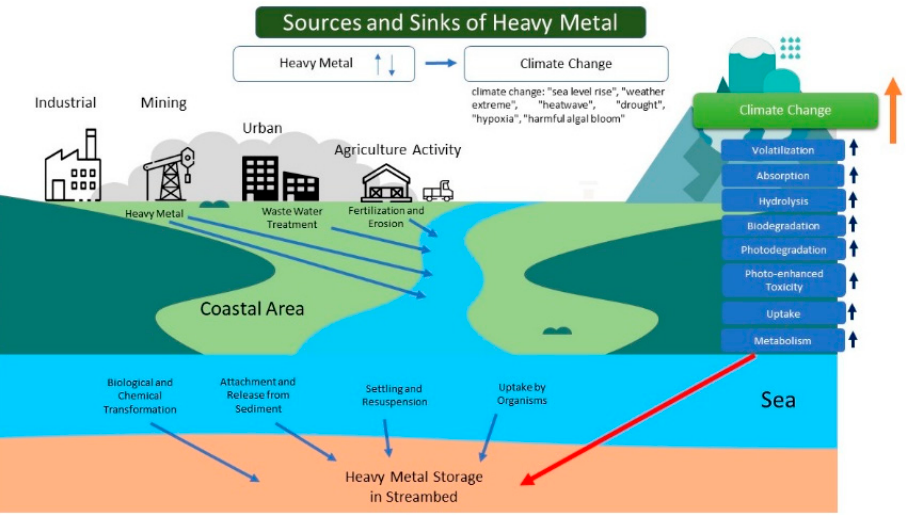
Figure 10. Anthropogenic stressors, such as industrialization, mining, urbanization and agriculture farming, that caused climate change and heavy metal contaminant pathways, while climate change also altered the heavy metals cycle at the coastal areas.